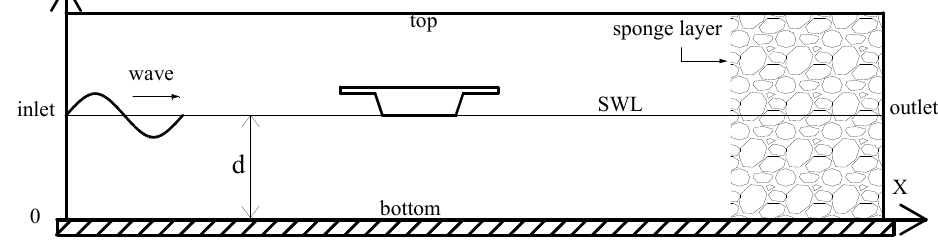
Figure 1. Schematic diagram for computational domain.